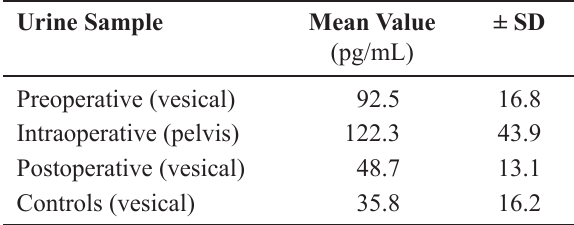
Table 1 – Urinary TGF-β1 values